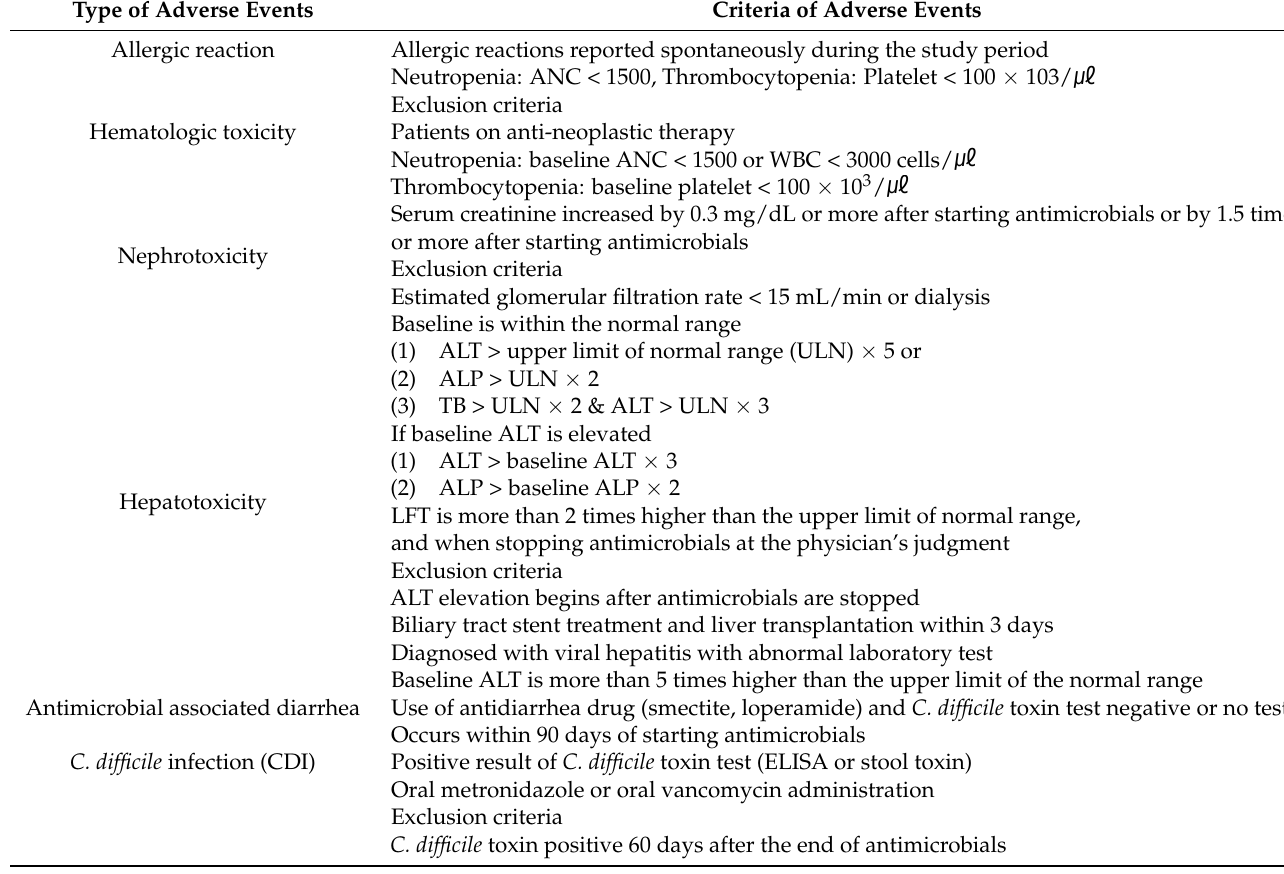
Table 4. Screening criteria of adverse events associated with antimicrobials.